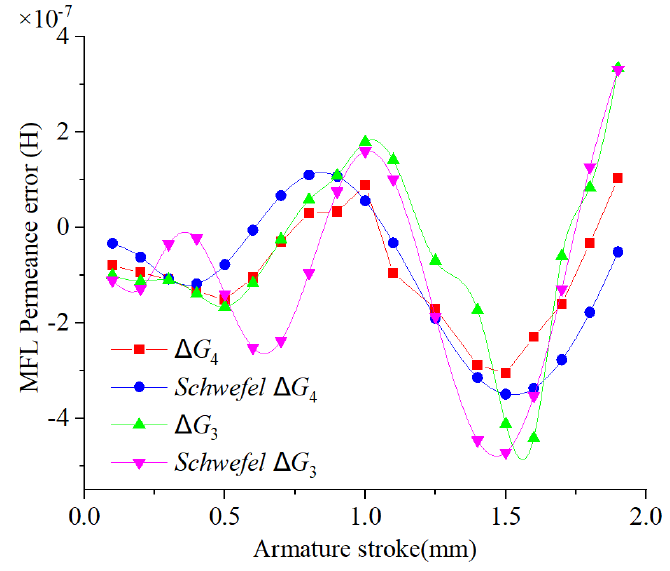
Figure 7. Schwefel function and Δ G 3 , Δ G 4 curves.